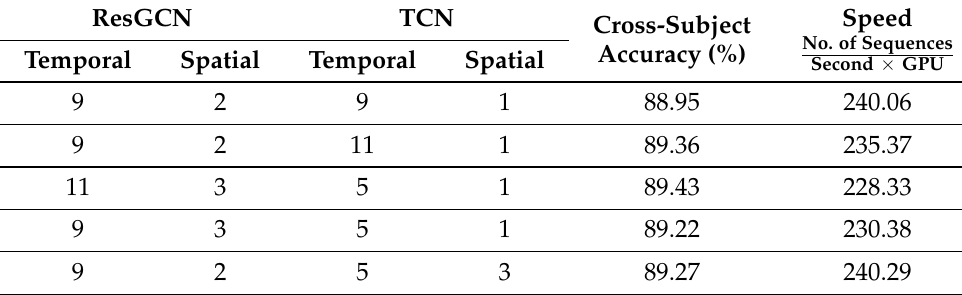
Table 3. Performances obtained depending on the size of the